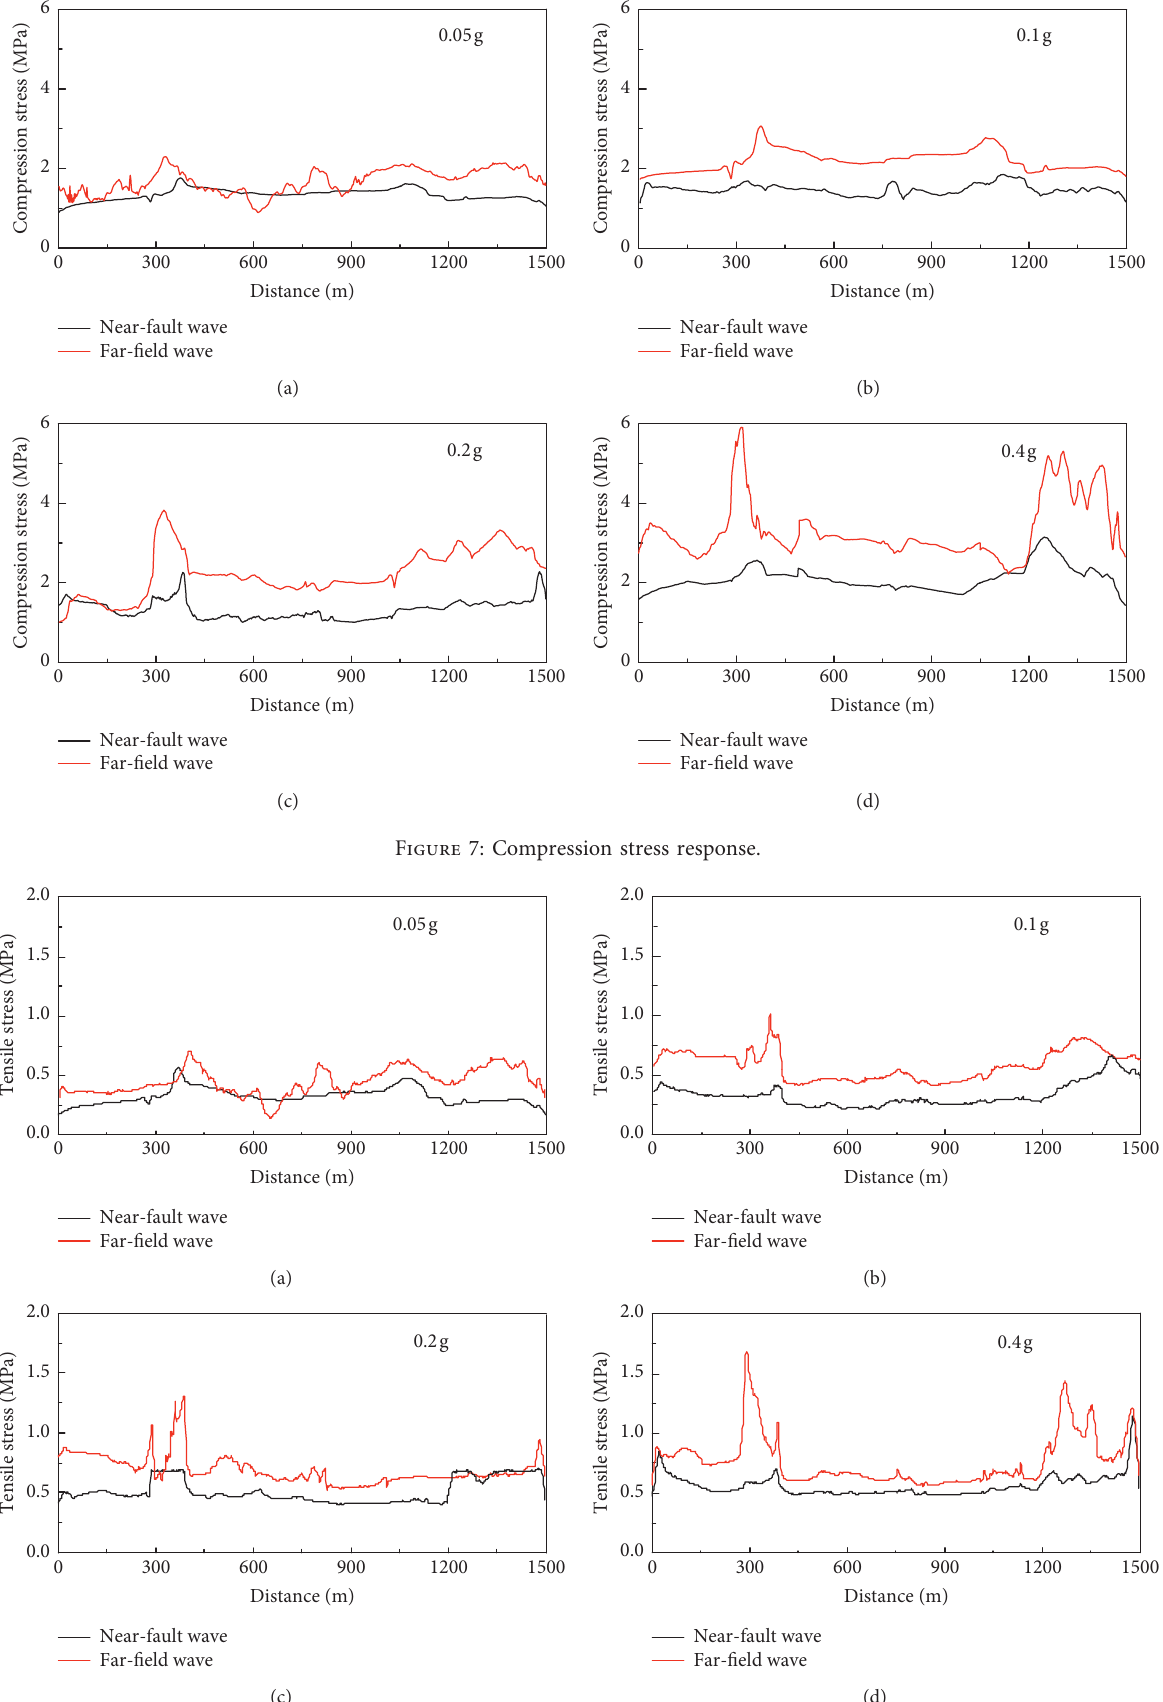
Figure 8: Tensile stress